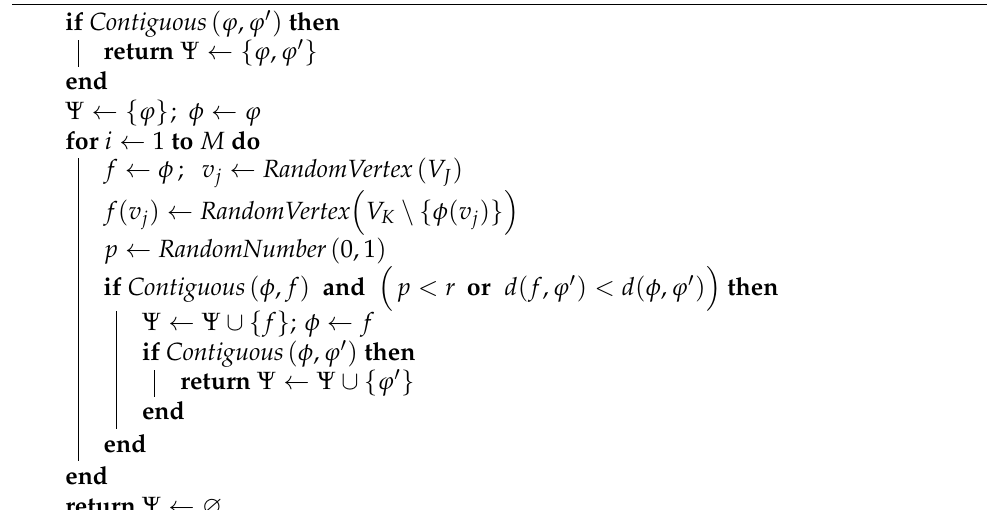
Algorithm 1: LocalSearch. Current element in Ψ is recorded by φ